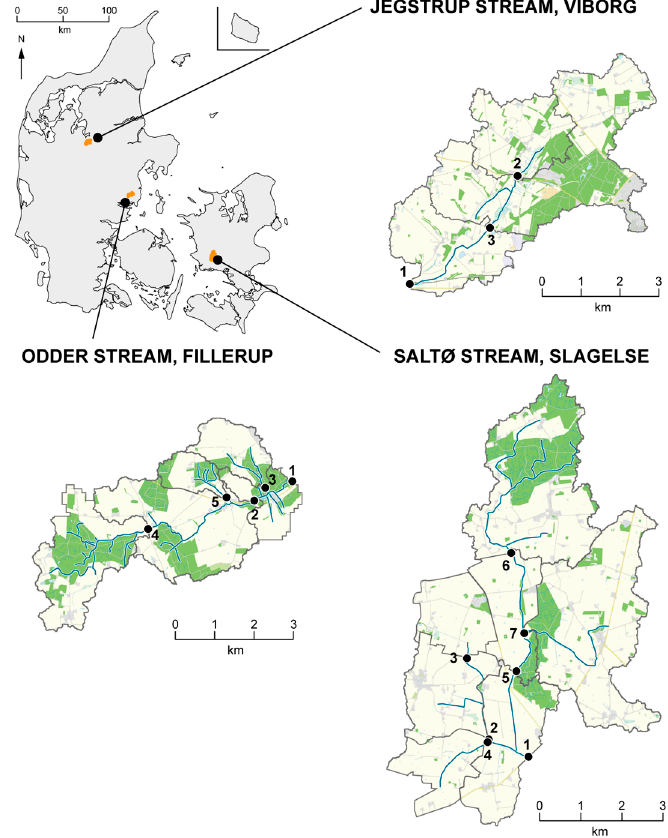
Figure 1. Overview map showing the location of the three study sites: Saltø stream catchment, Jegstrup stream catchment, and Odder stream catchment in Denmark. The numbers indicate the sub-catchments. Jegstrup stream catchment is divided into 3 sub-catchments, Odder stream catchment into 5 sub-catchments, and Saltø stream catchment into 7 sub-catchments.